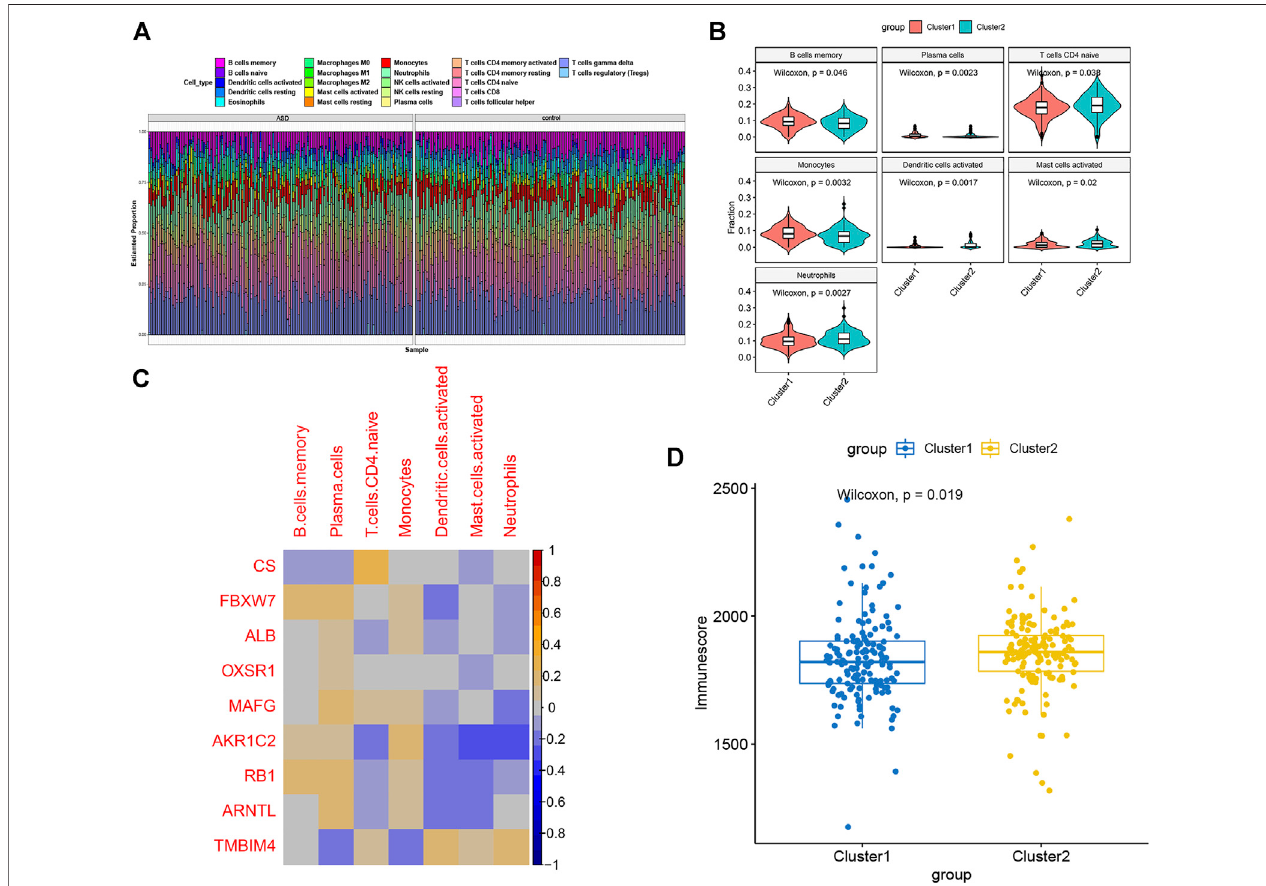
FIGURE 6 | Characteristics of immune in fi ltration cells between ferroptosis subtypes. (A) The relative proportions of the 22 immune cell subclasses in all 293 ASD samples. (B) Boxplotsshowingtheheterogeneityofin fi ltratedimmunecellsbetweenferroptosissubtypes. (C) Representativecorrelationheatmapbetweendifferentially expressed immune cells and FRGs. (D) Estimated Immunoscore between the two ferroptosis subtypes.